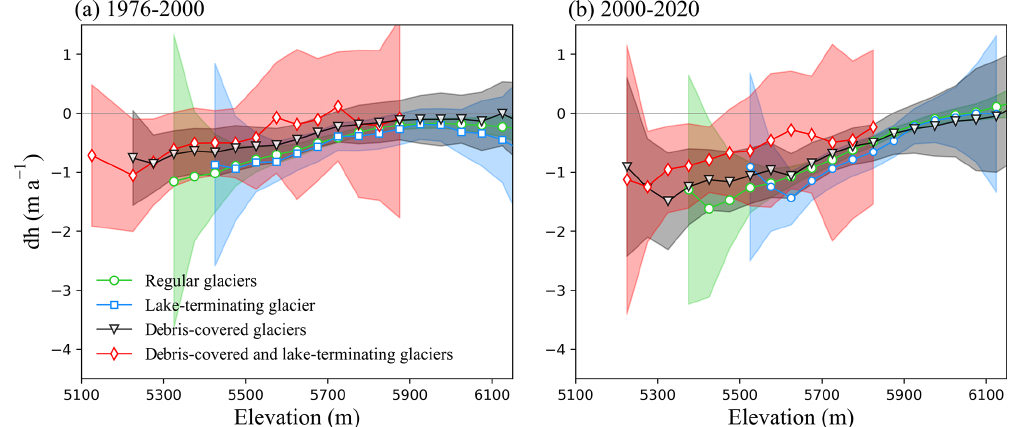
Figure 10. Rate of glacier elevation change with elevation of different glacier types during (a) 1976–2000 and (b) 2000–2020. Plots repre- sent the mean values of glacier elevation change in each 50m elevation bin, and shaded regions indicate the uncertainty in the altitudinal